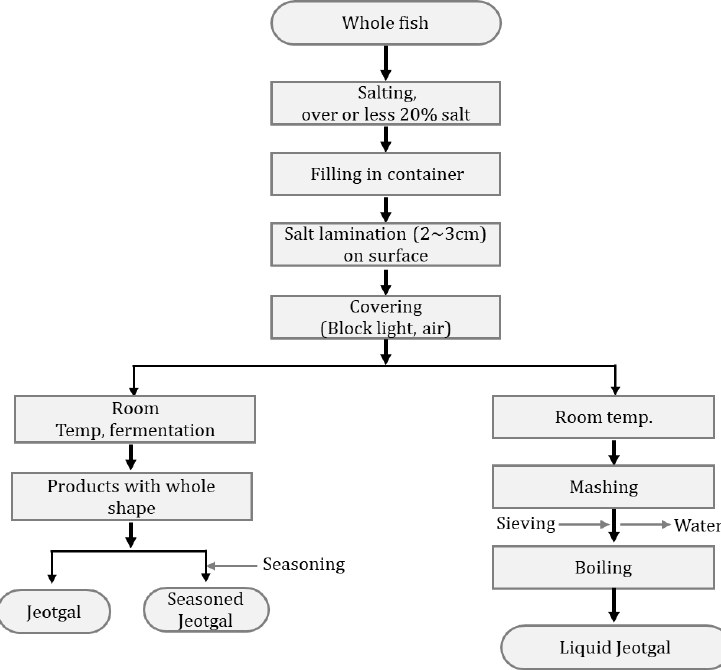
Figure 11. General manufacturing process of jeotgal.